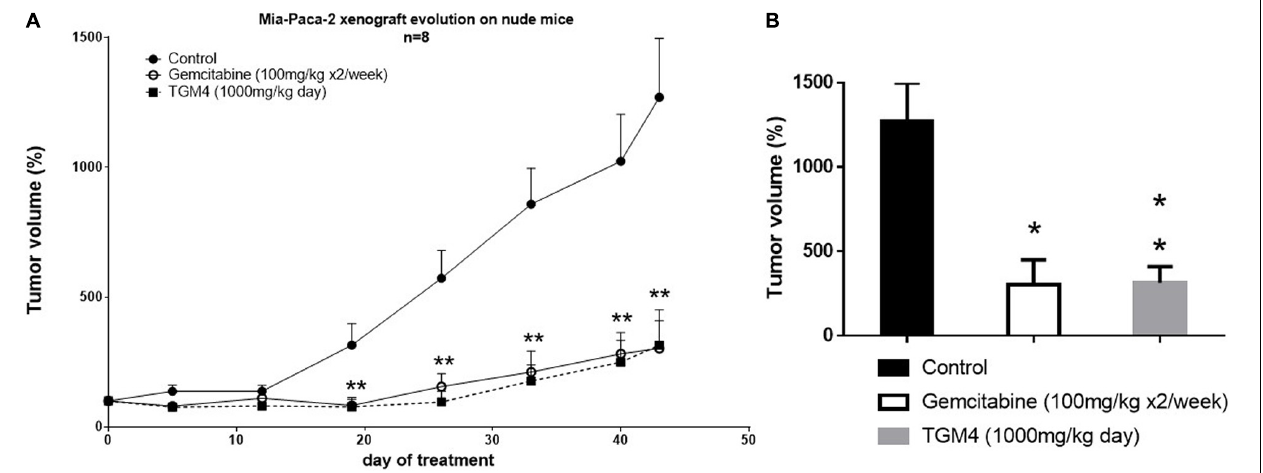
FIGURE 9 | Effect of TGM4 in xenograft model of pancreatic cancer (Mia-PaCa-2). A total of 7.5 × 106 Mia-PaCa-2 were injected subcutaneously in immunosuppressed nude Swiss Crl: NU (Ico) – Foxn1nu mice. Control animals received nothing or subcutaneous injections of 100 mg/kg of gemcitabine two times a week. The treated animals received through cannulation 1,000 mg/Kg of TGM4. (A) Changes in the tumors volumes through 43 days of treatment represented as percentage respect day 0. Significance indicates TGM4 against control. (B) Percentage of tumors volumes at day 43 of treatment. Each value represents the average of the percentages ± SEM ( n = 8) relative to day 0 (taken as 100%); non-parametric Mann–Whitney U test (* p < 0.05; ** p <